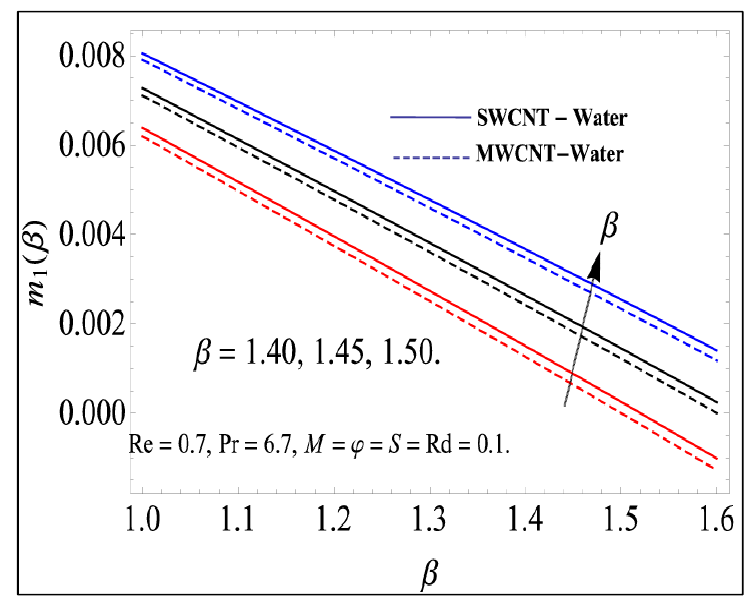
Figure 12. The impact of the thickness parameter β on the mass flux m 1 ( β ) .